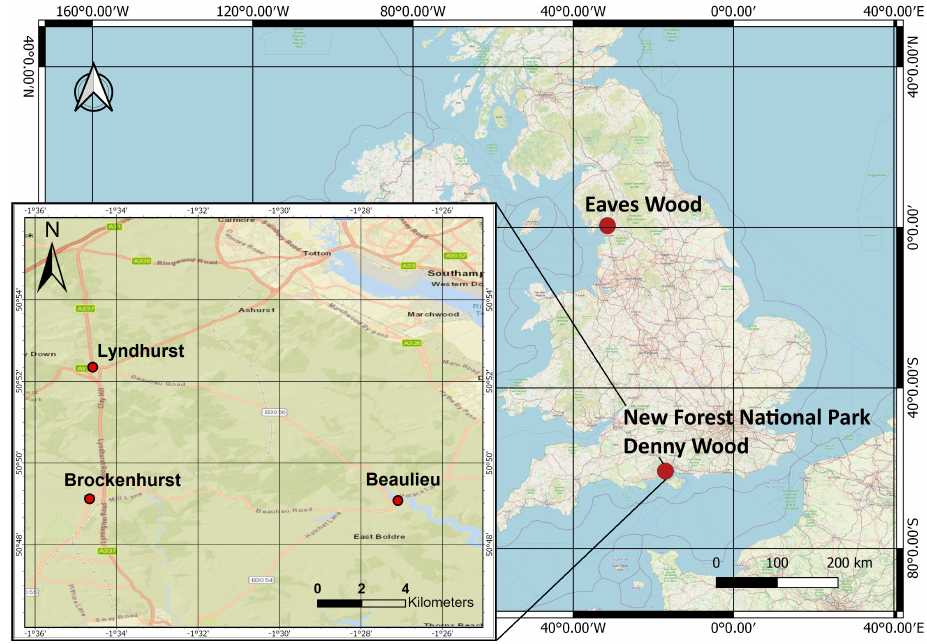
Figure 1. The study area, within the New Forest National Park, UK, lies between the three villages depicted: Brockenhurst, Lydhurst and